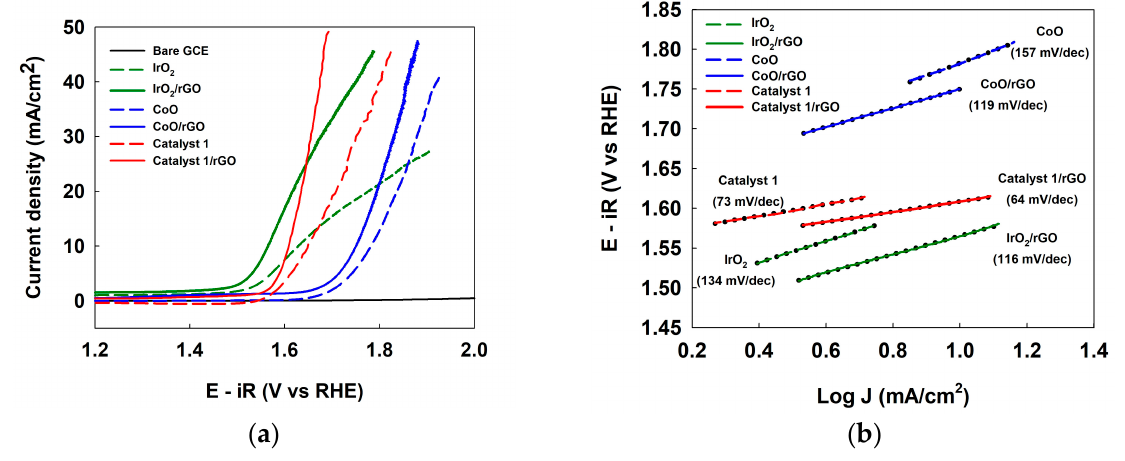
Figure 2. ( a ) Linear sweep voltammetry (LSV) and ( b ) Tafel plots of bare (black solid) glassy car- bon electrodes (GCEs), catalyst 1 /rGO composite- (red solid), catalyst 1 -(red dashed), CoO/rGO composite-(blue solid), CoO-(blue dashed), IrO 2 /rGO composite-(green solid), and IrO 2 -(green dashed) modified GCE in the OER. The electrolyte solution was O 2 -saturated 0.1 M KOH. A scan rate of 100 mV/s and a rotation rate of 1600 rpm were used for the rotating disk electrode (RDE). All potentials were reported after the IR